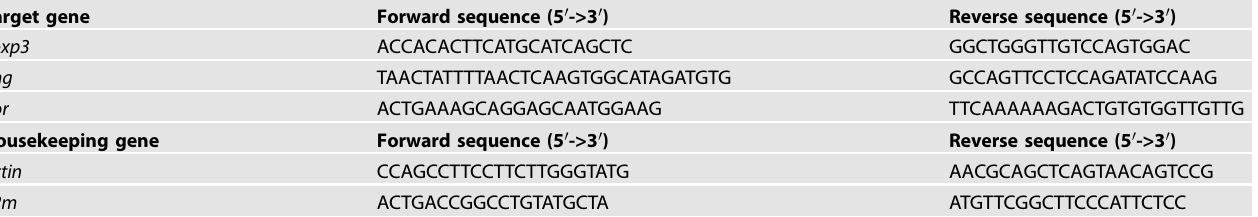
Table 1. Sequences of primers used for